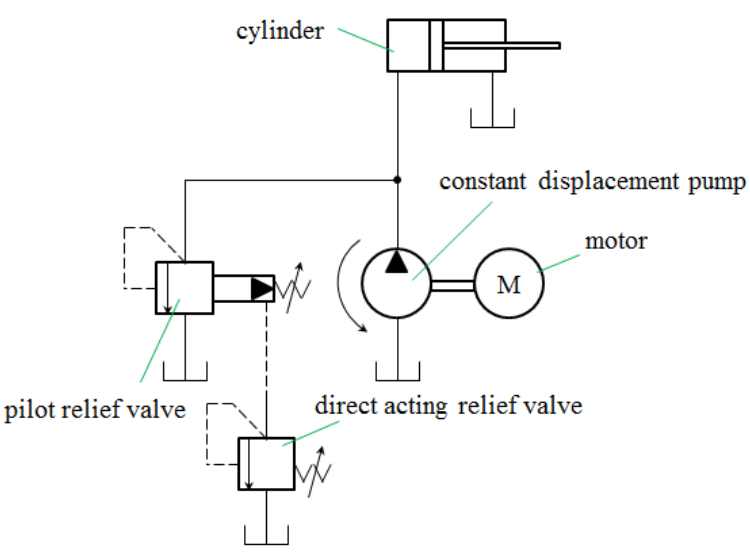
Figure 6. The remote pressure regulation circuit.